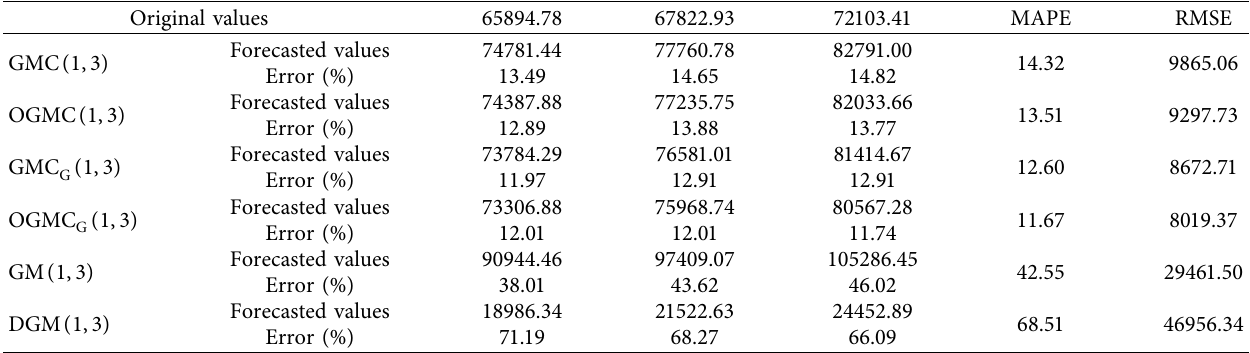
Table 9: The forecasted results and the values of three indices measuring accuracy by six competing models in case three. Original